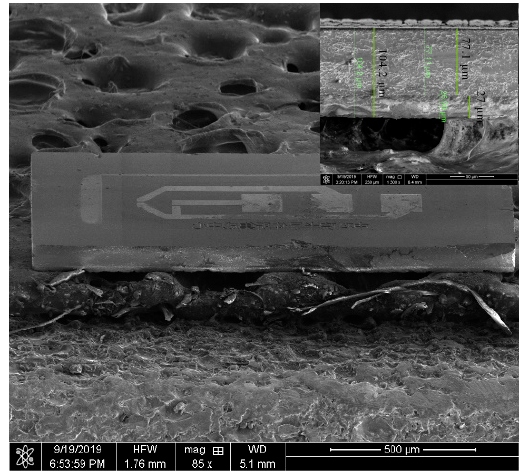
Figure 4. SEM image of the sensor die after separating the structures. The insert shows that there is a visible boundary between BF33 and the handle layer.